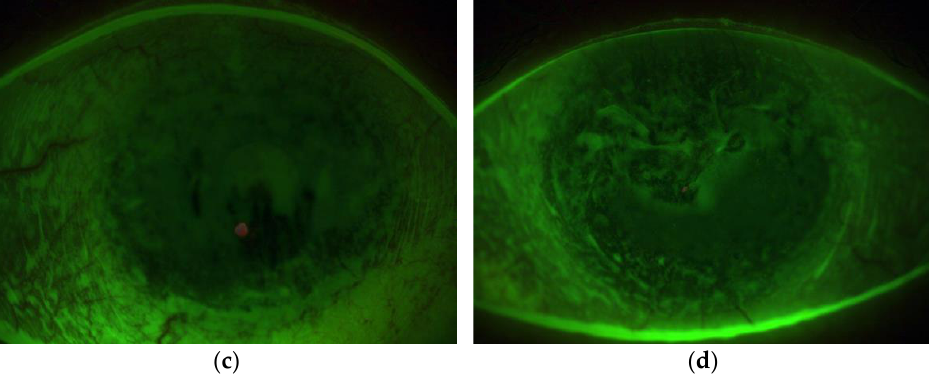
Figure 3. Slit-lamp biomicroscopy with and without fluorescent staining in a patient with bilateral LSCD. ( a , b ) Slit-lamp biomicroscopy images. Superficial peripheral corneal neovascularization on the right ( a ) and left ( b ) corneas. On the right eye ( a ) corneal epithelium is transparent and stable, but the palisades of Vogt are absent. On the left eye ( b ) conjunctival invasion from the upper limbus is reaching the optical center, the epithelium is edematous and opaque, and the palisades of Vogt are absent. ( c , d ) Slit-lamp biomicroscopy images and fluorescent staining with cobalt light and a yellow filter. The furrow staining pattern of the bulbar conjunctiva on the right ( c ) and left ( d ) eyes. Definitive line of conjunctival invasion of the left cornea, part of the corneal epithelium is retained ( d ). Diagnosis: BE — contact-lens induced bilateral partial LSCD, normal thickness of the corneal stroma in both eyes. The patient was enrolled in the clinical trial of paralimbal oral mucosa epithe- lium transplantation (PLOMET) on the left eye (NCT04995926).